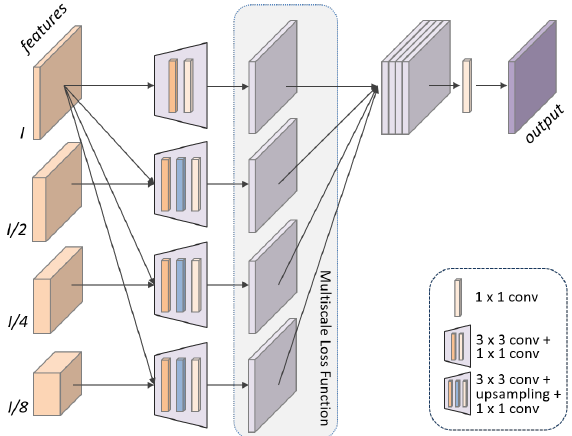
Figure 3. Illustration of multilevel supervision